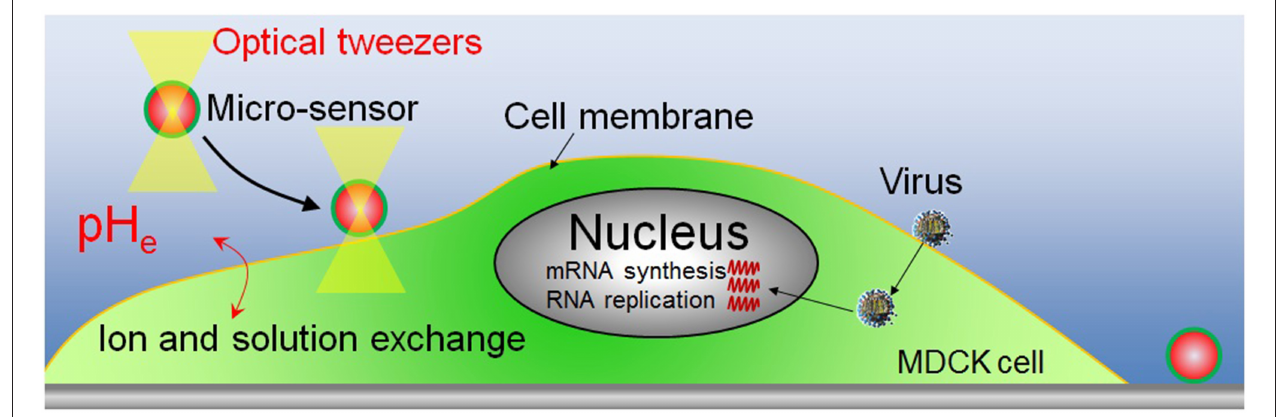
FIGURE 1 | Schematic of the pH e measurement of virus-infected cell by pH sensor adhered on cell membrane.